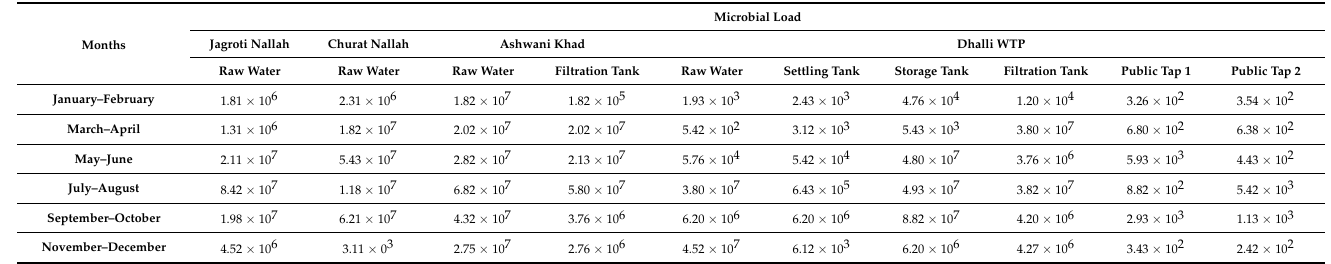
Table 5. Microbial load of different water samples.